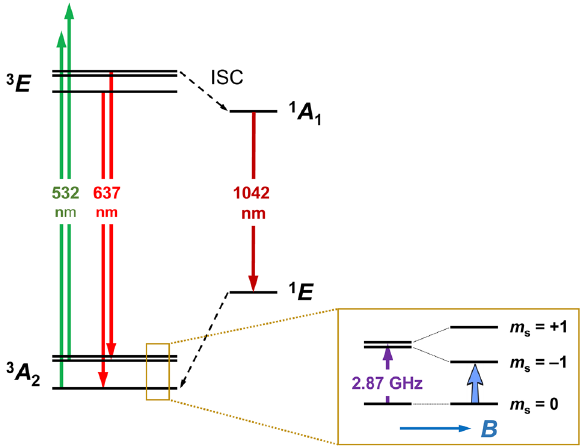
Figure 2. Energy level diagram of the NV − center in diamond. ISC intersystem